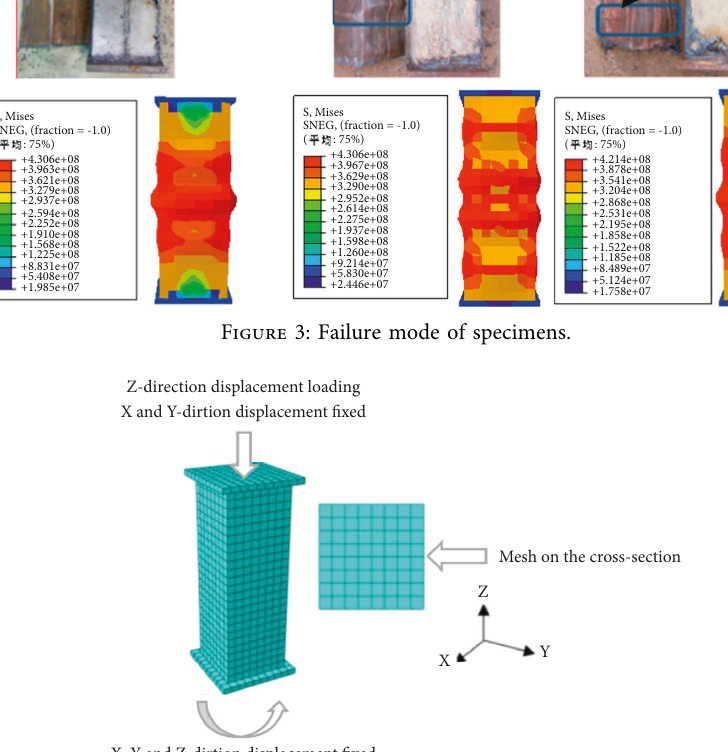
Figure 4: Mesh division and constraint loading